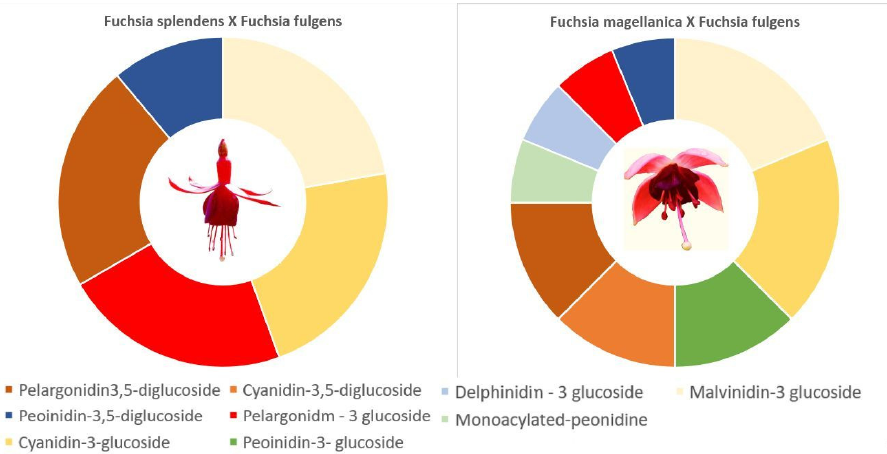
Figure 1. Distribution of anthocyanins in fuchsia hybrids